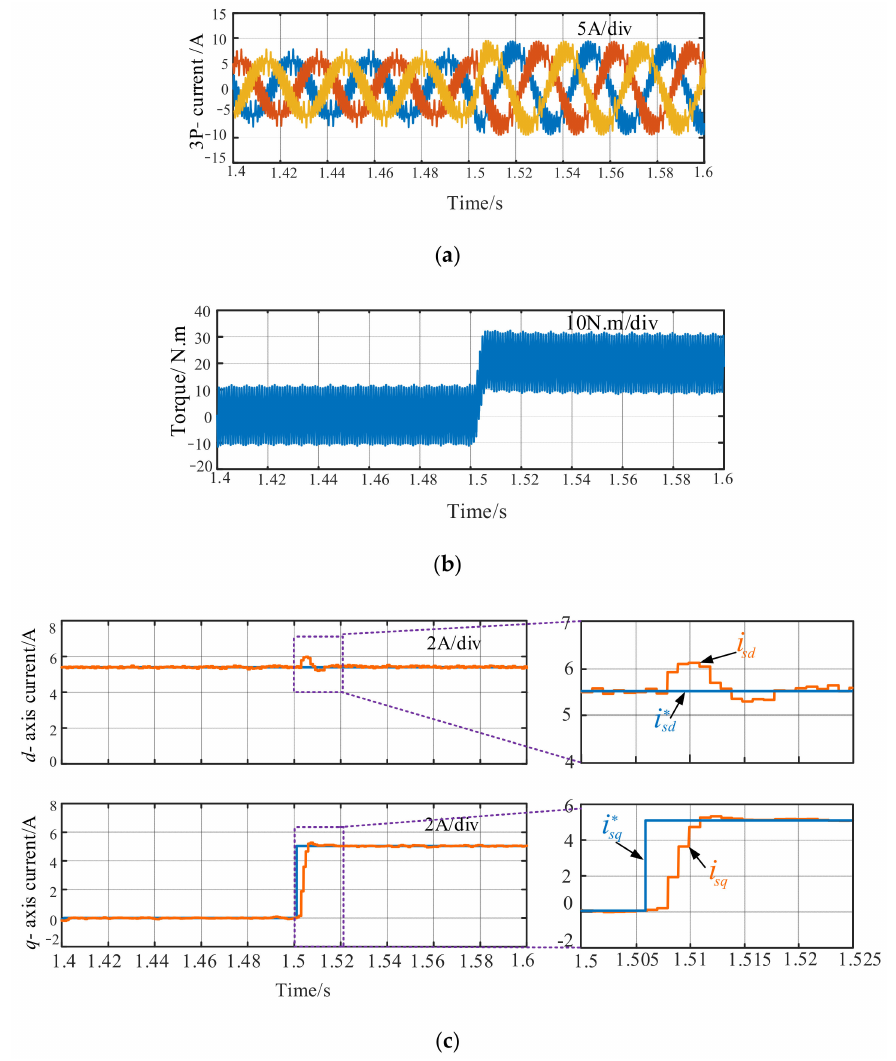
Figure 20. Current loop characteristics of the improved complex vector current decoupling con- troller: ( a ) Three-phase stator current; ( b ) Electromagnetic torque sudden change process; ( c ) dq -axis current